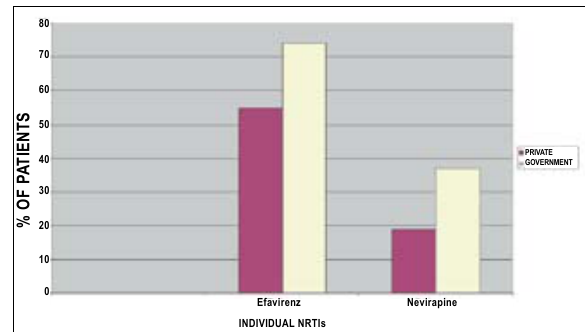
Fig. 2. Non-nucleoside reverse transcriptase inhibitor use by patients in the private sector (%) compared with combined use by all patients in the government programme (%).